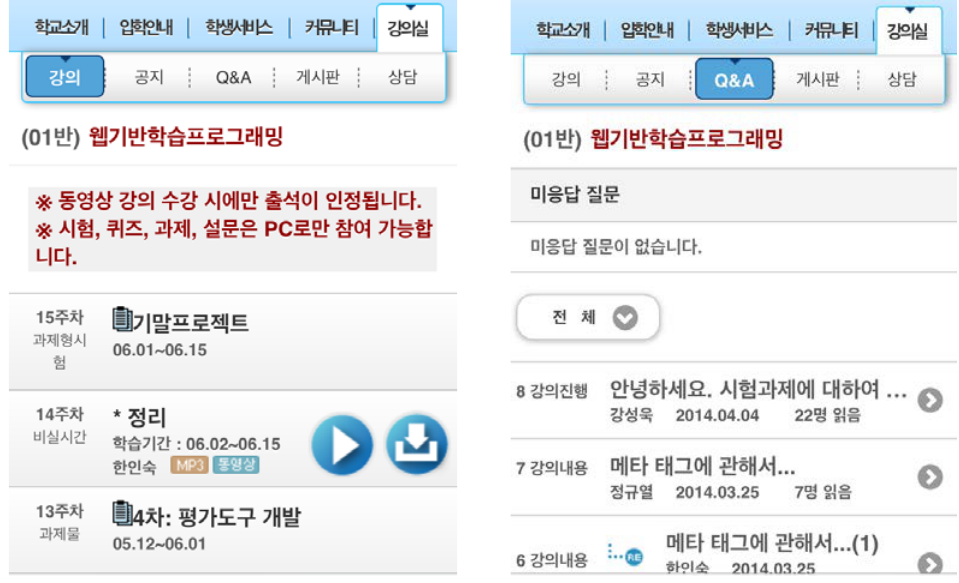
Figure 2 . Lecture lists (left) and Q&A (right) in the virtual